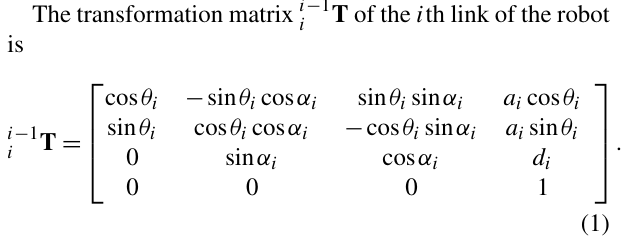
The transformation matrix i − 1